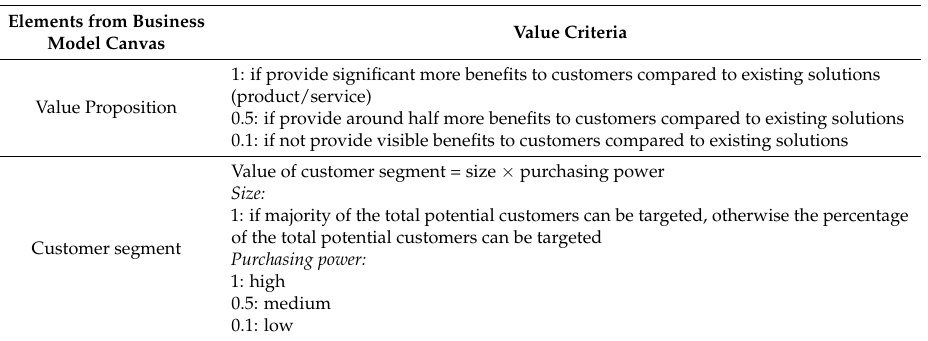
Table 4. TOWS analysis and strategy